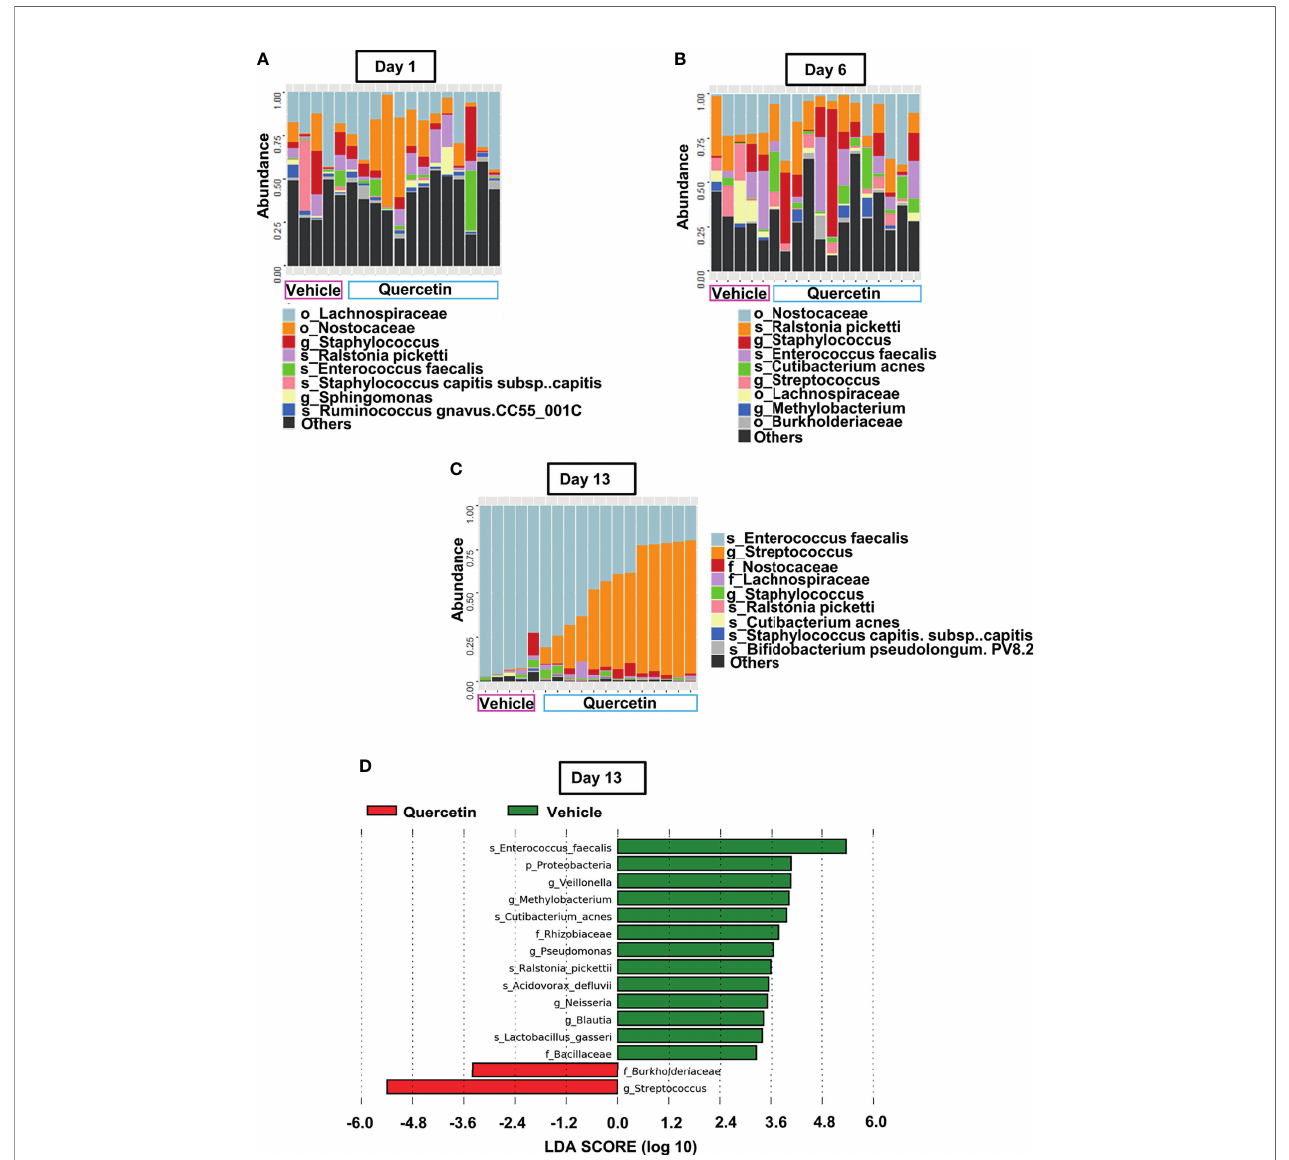
FIGURE 3 | Quercetin Treatment Alters Microbial Composition Induced by Periodontitis. (A – C) Prominent bacterial taxa in 5 vehicle- and 13 Quercetin-treated mice at Day 1 (A) , Day 6 (B) and Day 13 (C) . (D) Signi fi cantly altered taxa in Quercetin treated compared to vehicle treated mice after periodontitis onset (Day 13) as determined by linear discriminant analysis effect size (LDA) scores using Silva-132 classi fi